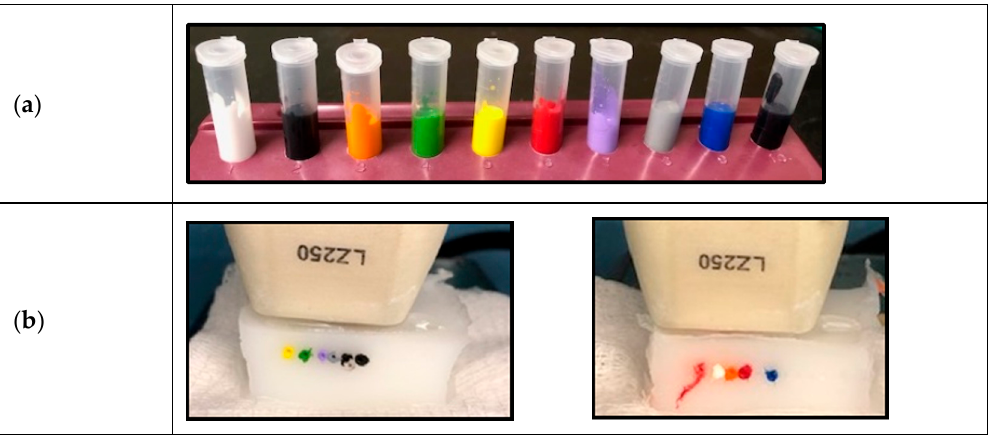
Figure 1. ( a ) Photograph showing the ten commercially available tattoo ink samples evaluated in vitro. ( b ) Set up for evaluation of photoacoustic properties of tattoo inks using hollow channels created in a tissue mimicking phantom.